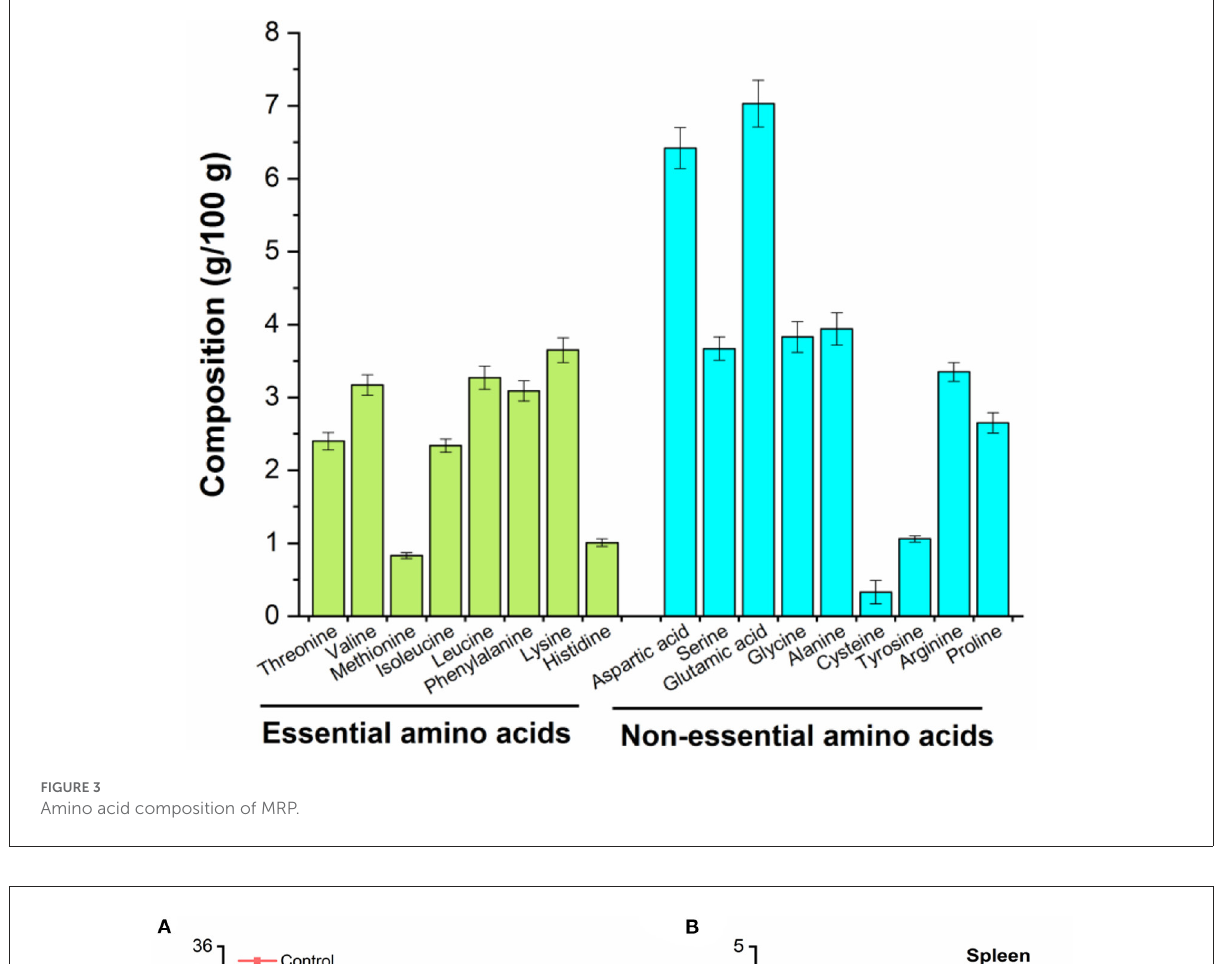
FIGURE3 Amino acid composition of MRP.